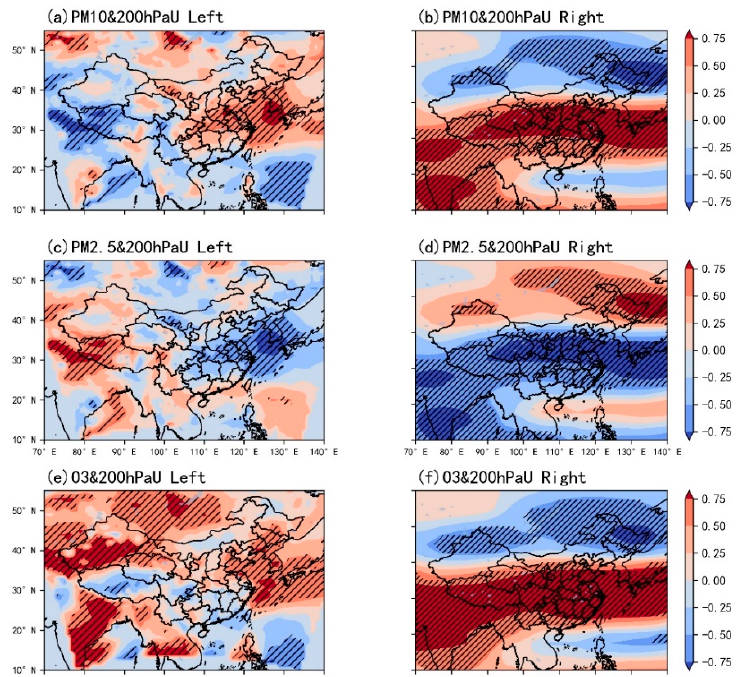
Figure 10. The ( a , c , e ) left and ( b , d , f ) right heterogeneous correlation diagrams of the SVD1 of the surface pollutants including the PM 10 , O 3 and PM 2.5 (the left field) and the 200 hPa zonal wind field (the right field) in summer from 2013 to 2018. The slashes indicate that the results passed the 95% Monte Carlo correlation test.